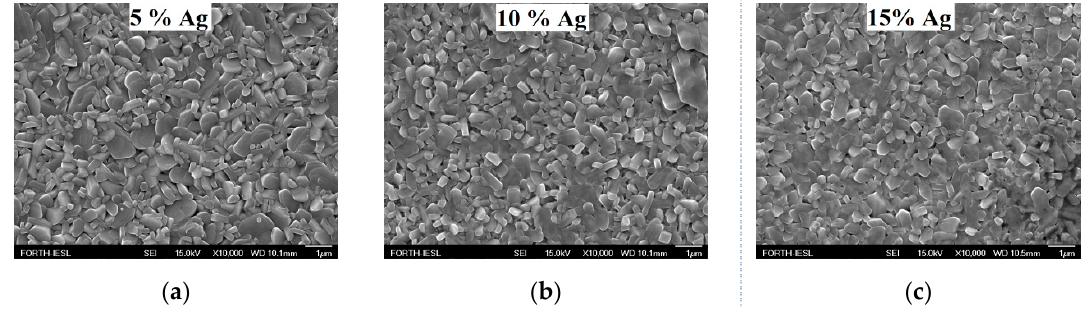
Figure 2. FE-SEM images of V 2 O 5 grown by AACVD under atmospheric pressure for ( a ) 5%, ( b ) 10%, and ( c ) 15% Ag loading at 400 °C for 1 h.